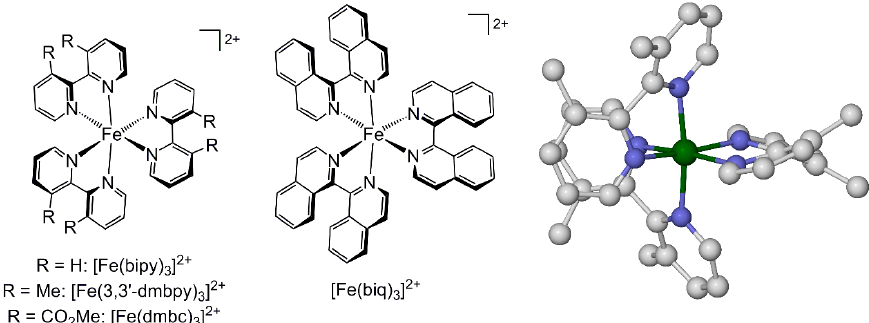
Figure 4. [Fe(bipy) 3 ] 2+ derivatives designed to adopt twisted ligand conformations, and the crystal structure of [Fe(3,3 ′ -dmbpy) 3 ] 2+ oriented to emphasize the twisting of the bipyridyl framework [62]. Color code: C, white; H, pale gray; Fe, green; N, blue.